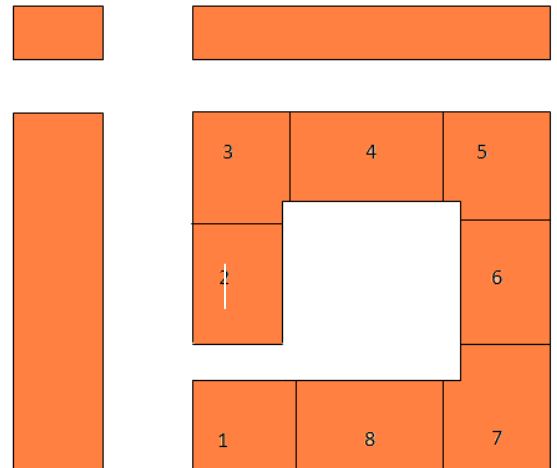
Figure 2. Top view of the one of the periods of the model representing the layout of the apartments at each